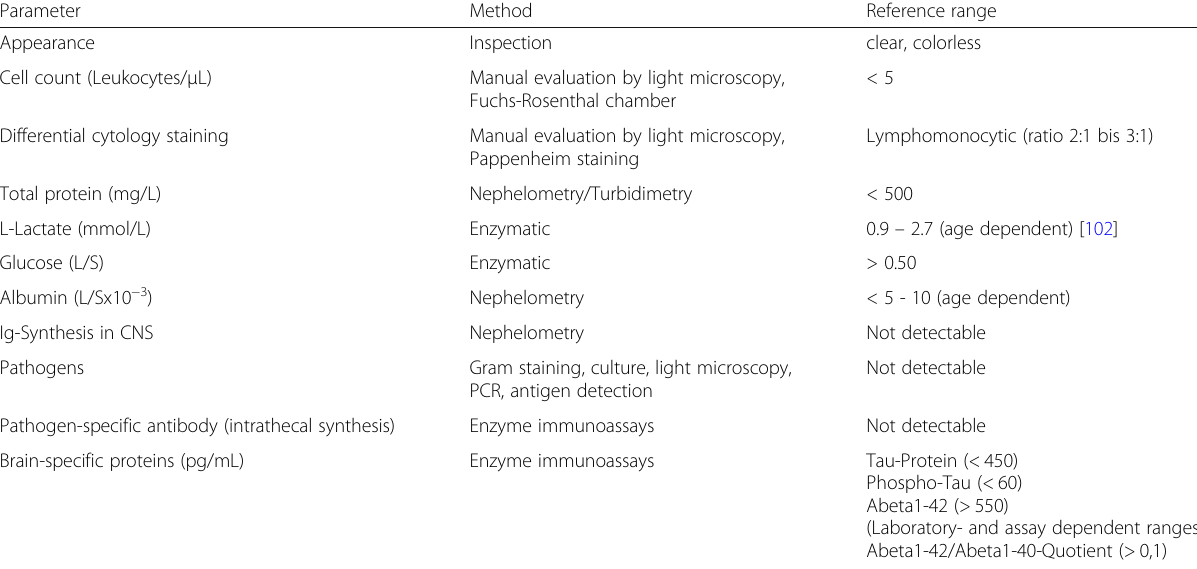
Table 4 Reference ranges for routine